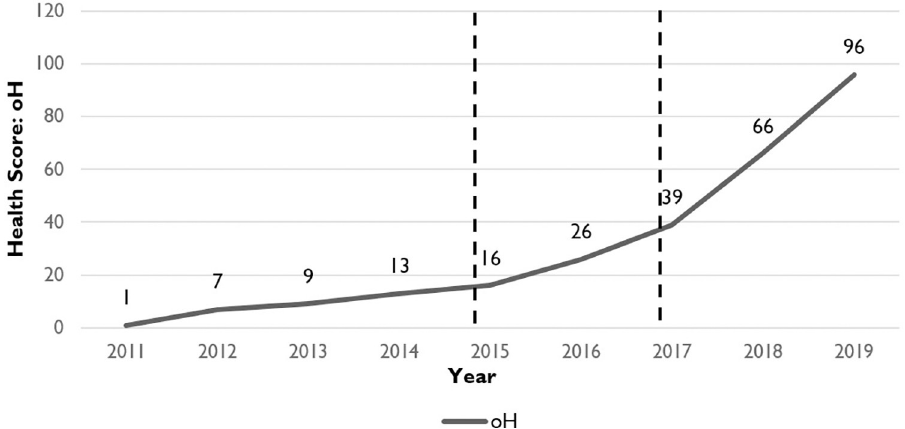
Fig 1. Health of pharmaceutical innovative ecological rainforest in Zhejiang Province: 2011–2019.